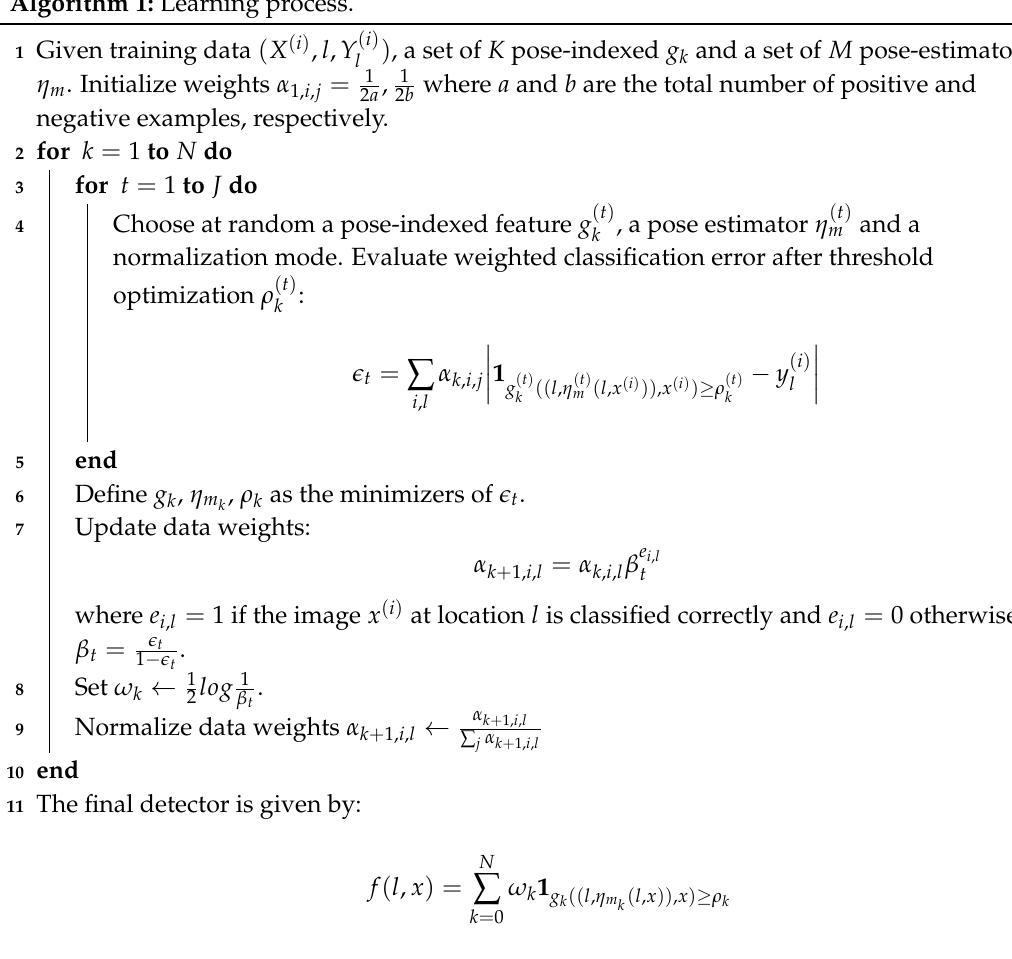
Algorithm 1: Learning process.